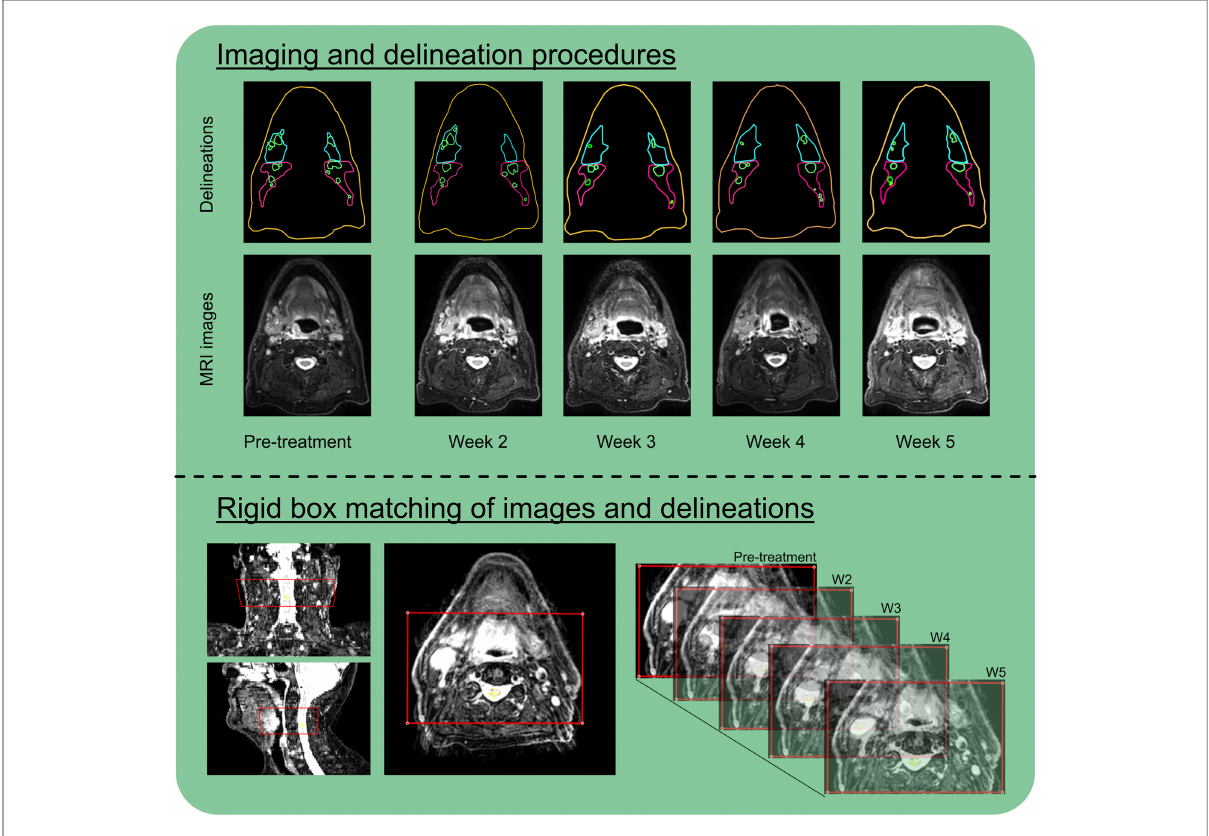
FIGURE 1 For this study per patient in total 5 MRI scans were obtained in which elective lymph nodes and lymph nodes levels were delineated (top). All scans and delineations were rigidly matched using a box around spine and lymph node levels at the level of the tumor